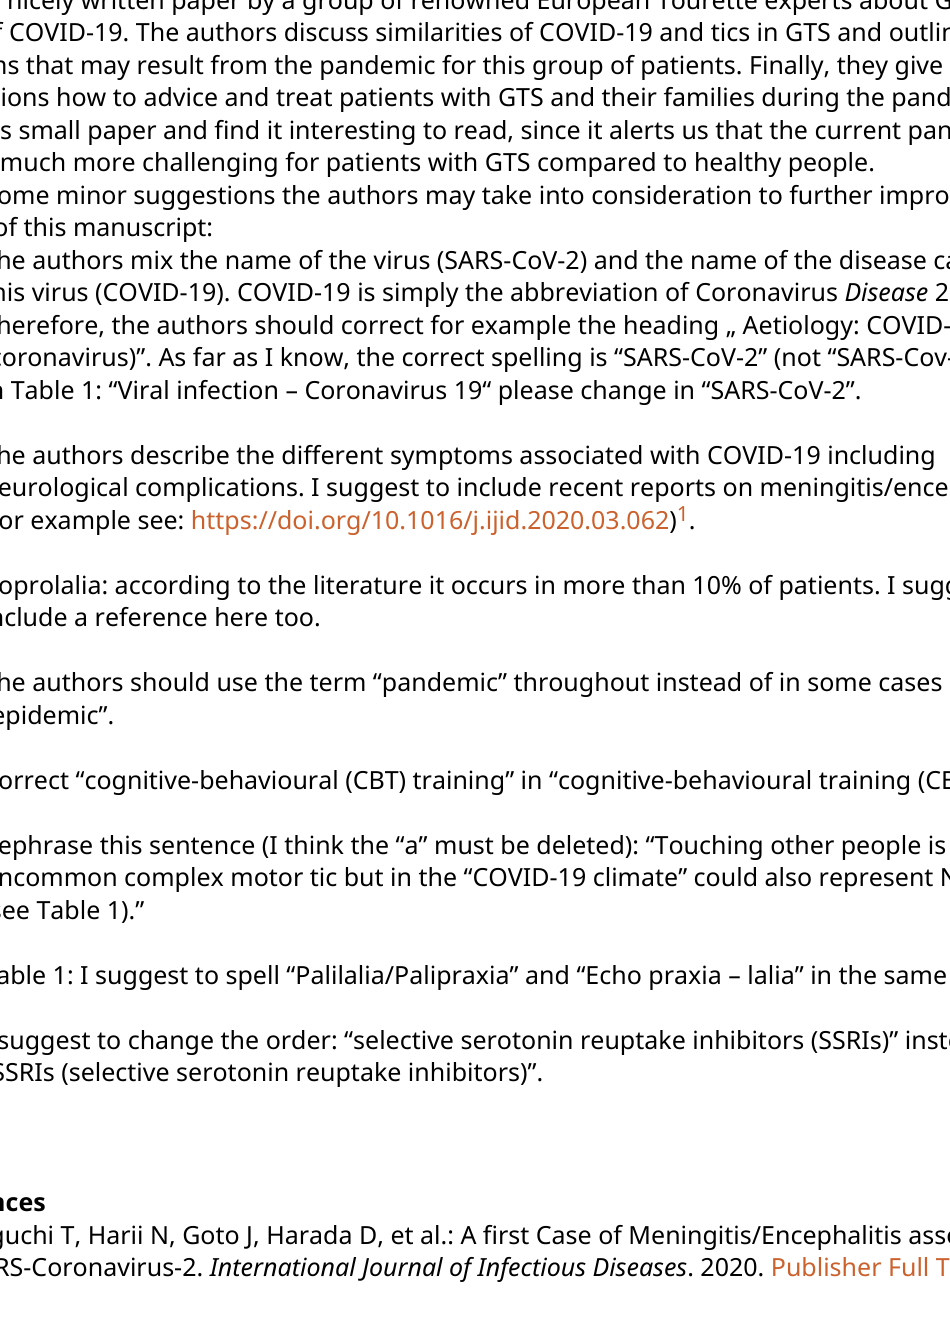
I suggest to change the order: “selective serotonin reuptake inhibitors (SSRIs)” instead of “SSRIs (selective serotonin reuptake